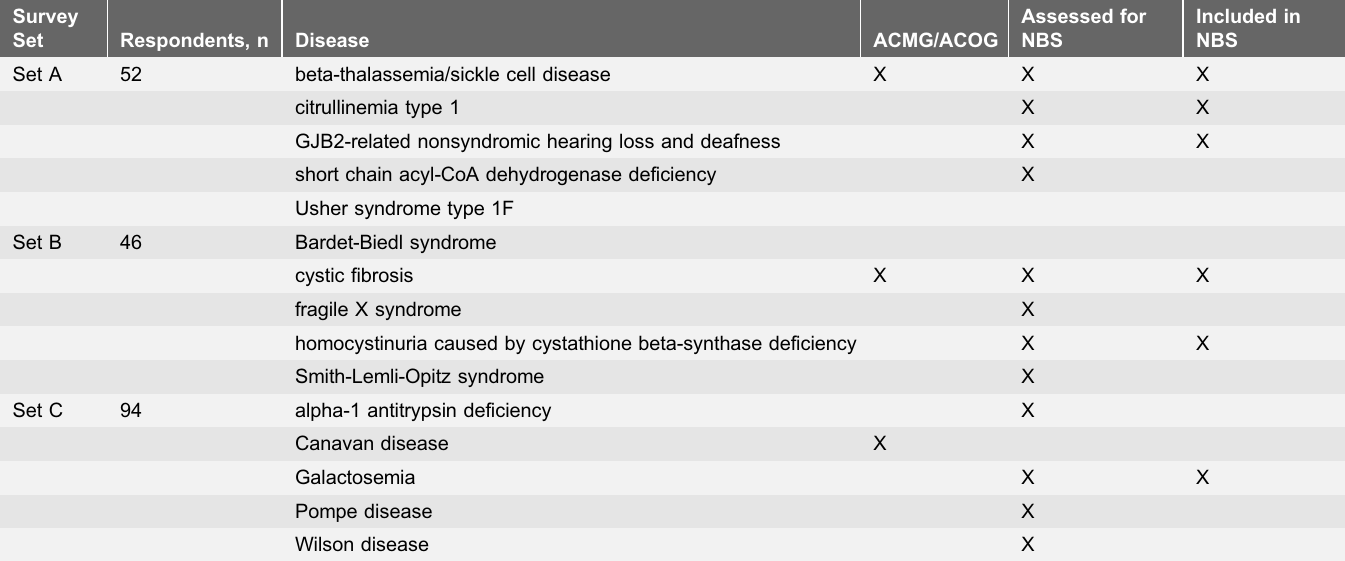
Table 2. Number of respondents for each set of diseases and disease